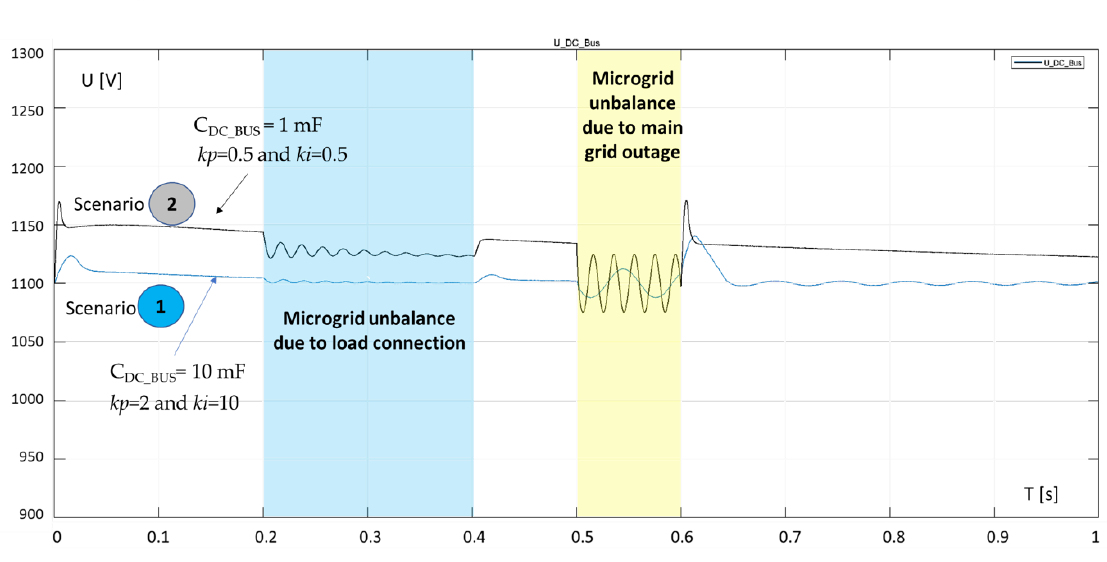
Figure 10. Superposition of the SST DC bus voltage variation in both scenarios (1 and 2).